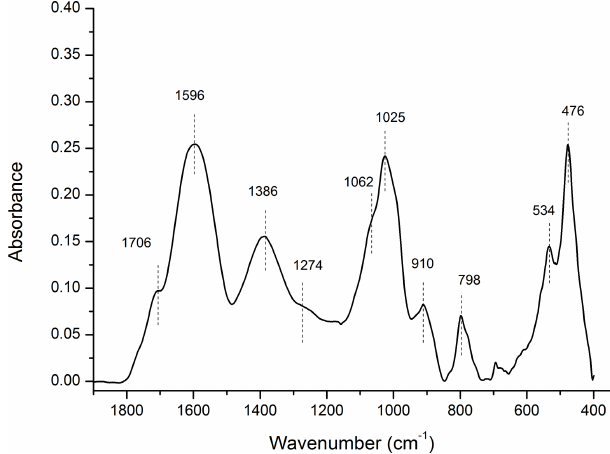
Figure 7. The FTIR spectra for the chemistry of organo-mineral as- sociation. The aged OC is highly aromatic (1596 and 1386cm − 1 ) , and highly reactive with obvious carboxyl functional group (1706cm − 1 ) . The broad bands likely point to a significant degree of association between OC and minerals. Some minor bands near 1274, 1062, 1024, and 989cm − 1 indicate the lignin-derived nature of OC. The bands near 1025, 910, 798, 534, and 476cm − 1 have similar characteristics of soil inorganic/mineral matrix. More de- tails are included in Table